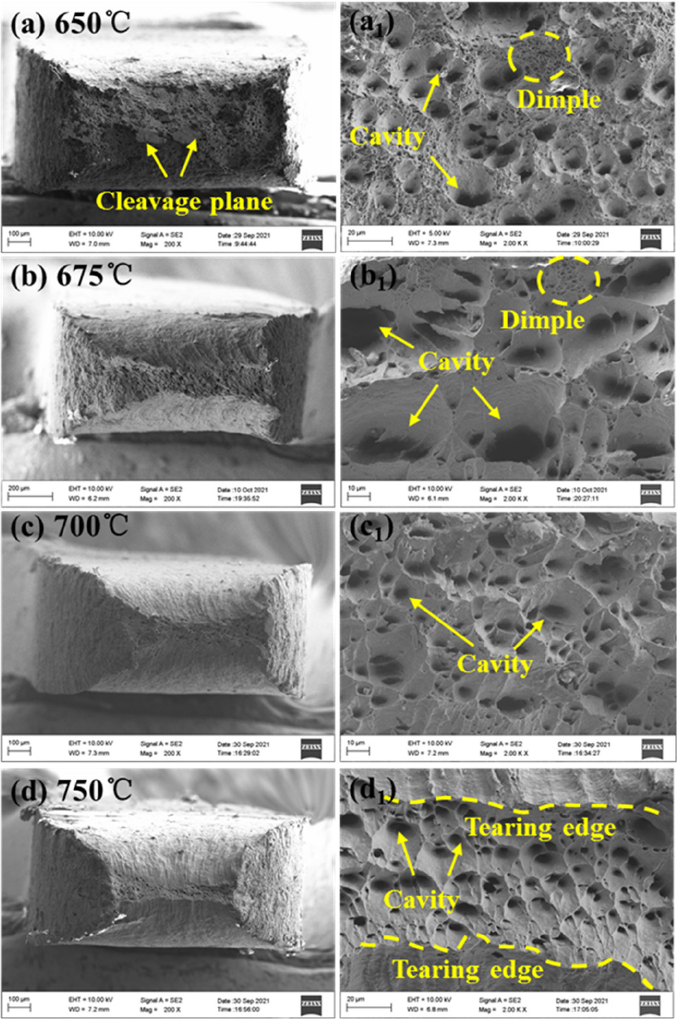
Figure 4. Typical SEM fractographs of T91 steel creep at ( a , a 1 ) 650 °C, ( b , b 1 ) 675 °C, ( c , c 1 ) 700 °C, and ( d , d 1 ) 750 °C .